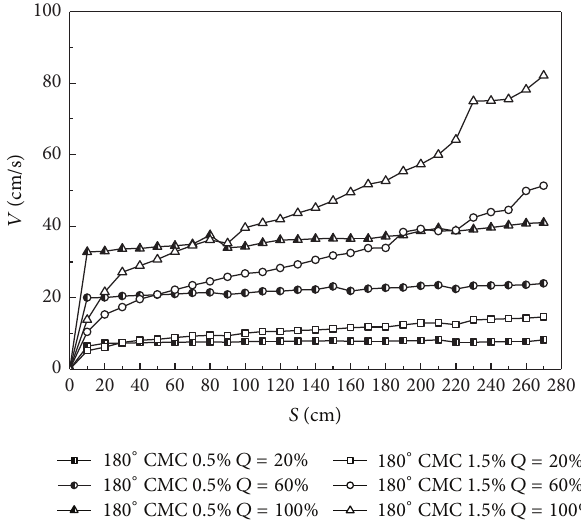
Figure 12: The PAS velocity-position diagram of various flow in 180 ∘ curved tube.